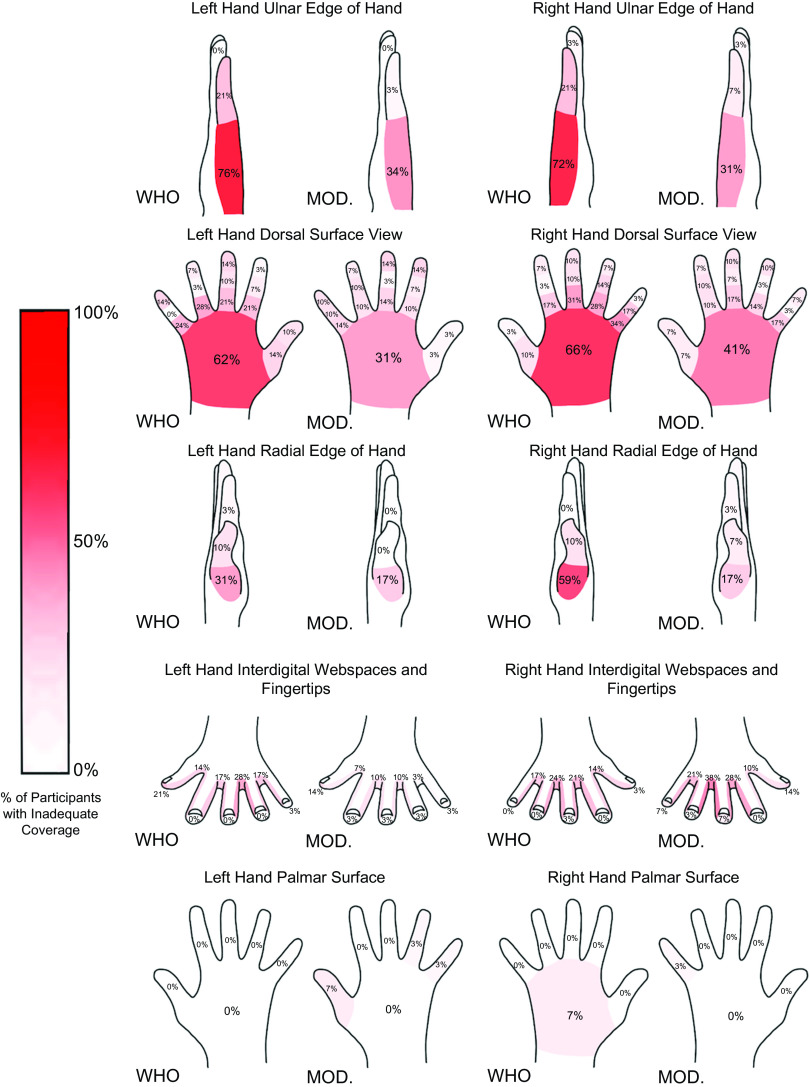
Heat maps of inadequate coverage for both hands and both diagrams. Data represent the percentage of participants who had inadequate coverage (gaps or no coverage) of the indicated area.